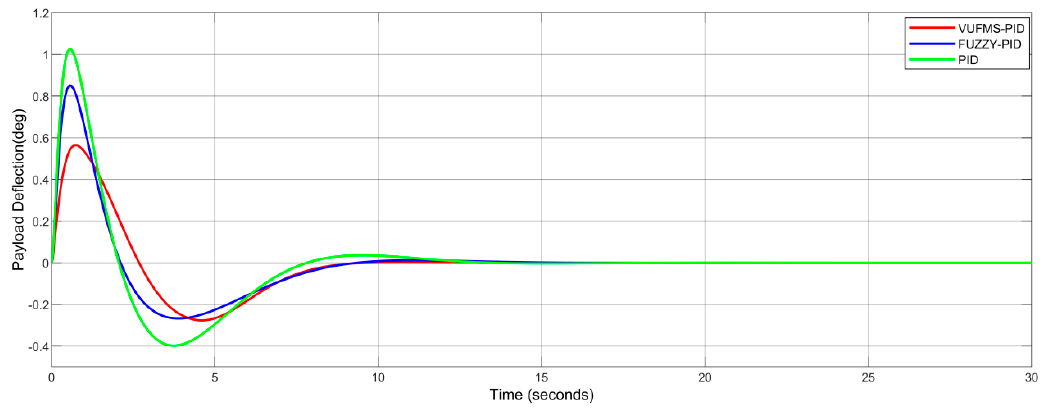
Table 7. Performances obtained using VUFMS-PID, FUZZY-PID, and PID controller under work- ing condition 2. Figure 13. Payload’s swing angle ( θ ) using VUFMS-PID, FUZZY-PID and PID controller under working condition 3. Table 6. Performances obtained using VUFMS-PID, FUZZY-PID, and PID controller under working condition 1.